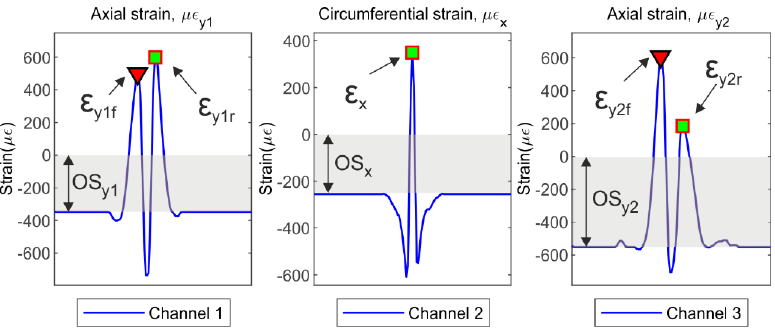
Figure 3. Features of the tire strain curve (0°, 0.8 bar, 500 N, 50 km/h).